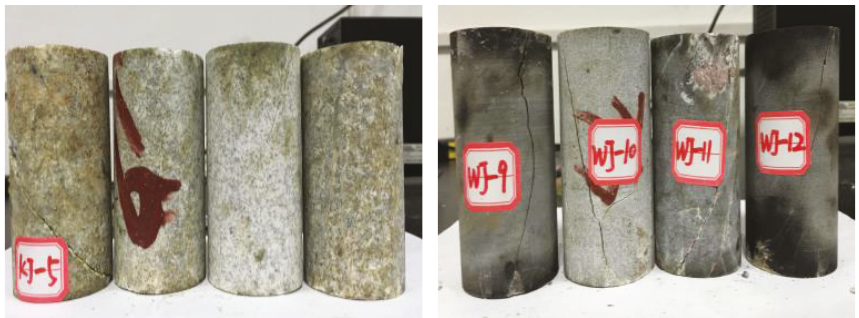
Figure 11: Shear failure mode of surrounding rock and ore rock specimen.